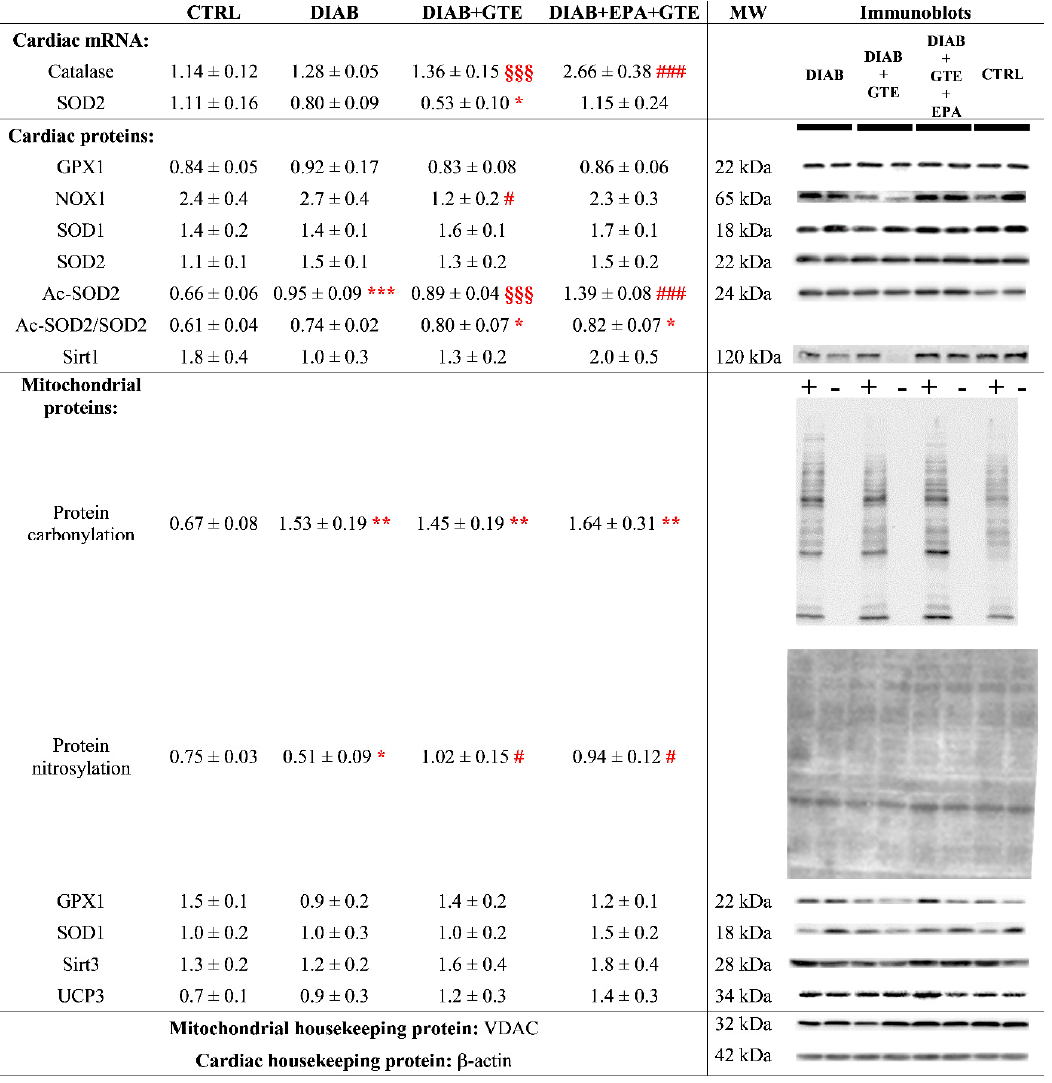
Figure 7. Oxidative stress parameters. CTRL: Control group; DIAB: Diabetic rats; GTE: Green tea extract enrichment; EPA: Eicosapentaenoic acid enrichment; + : Sample processed to detect protein carbonylation; − : Negative control of protein carbonylation; and MW: Molecular weight. *: Di ff erent to the CTRL group; #: Di ff erent to the DIAB group; §: DIAB + GTE group di ff erent to the DIAB + EPA + GTE group. One symbol: p < 0.05; two symbols: p < 0.01; and three symbols: p < 0.001.